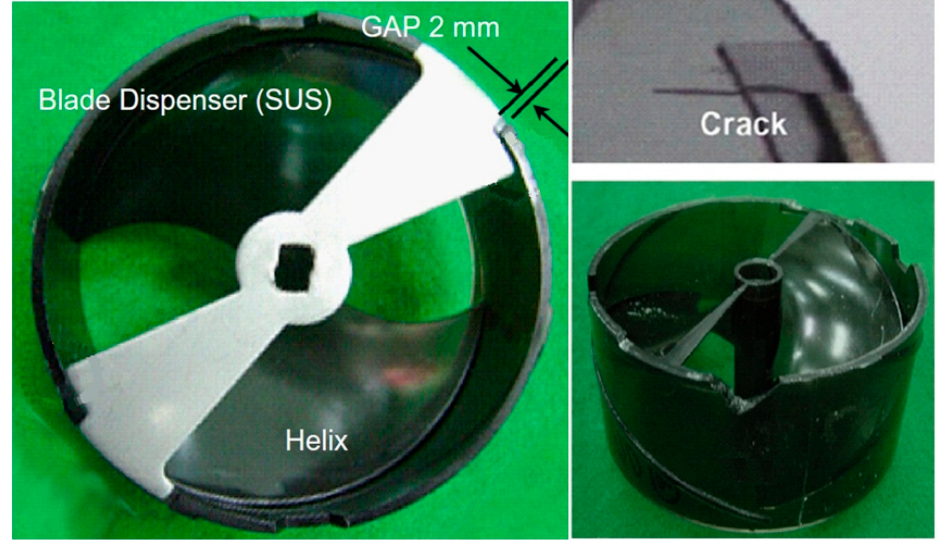
Figure 5. Damaged helix upper dispenser after use.